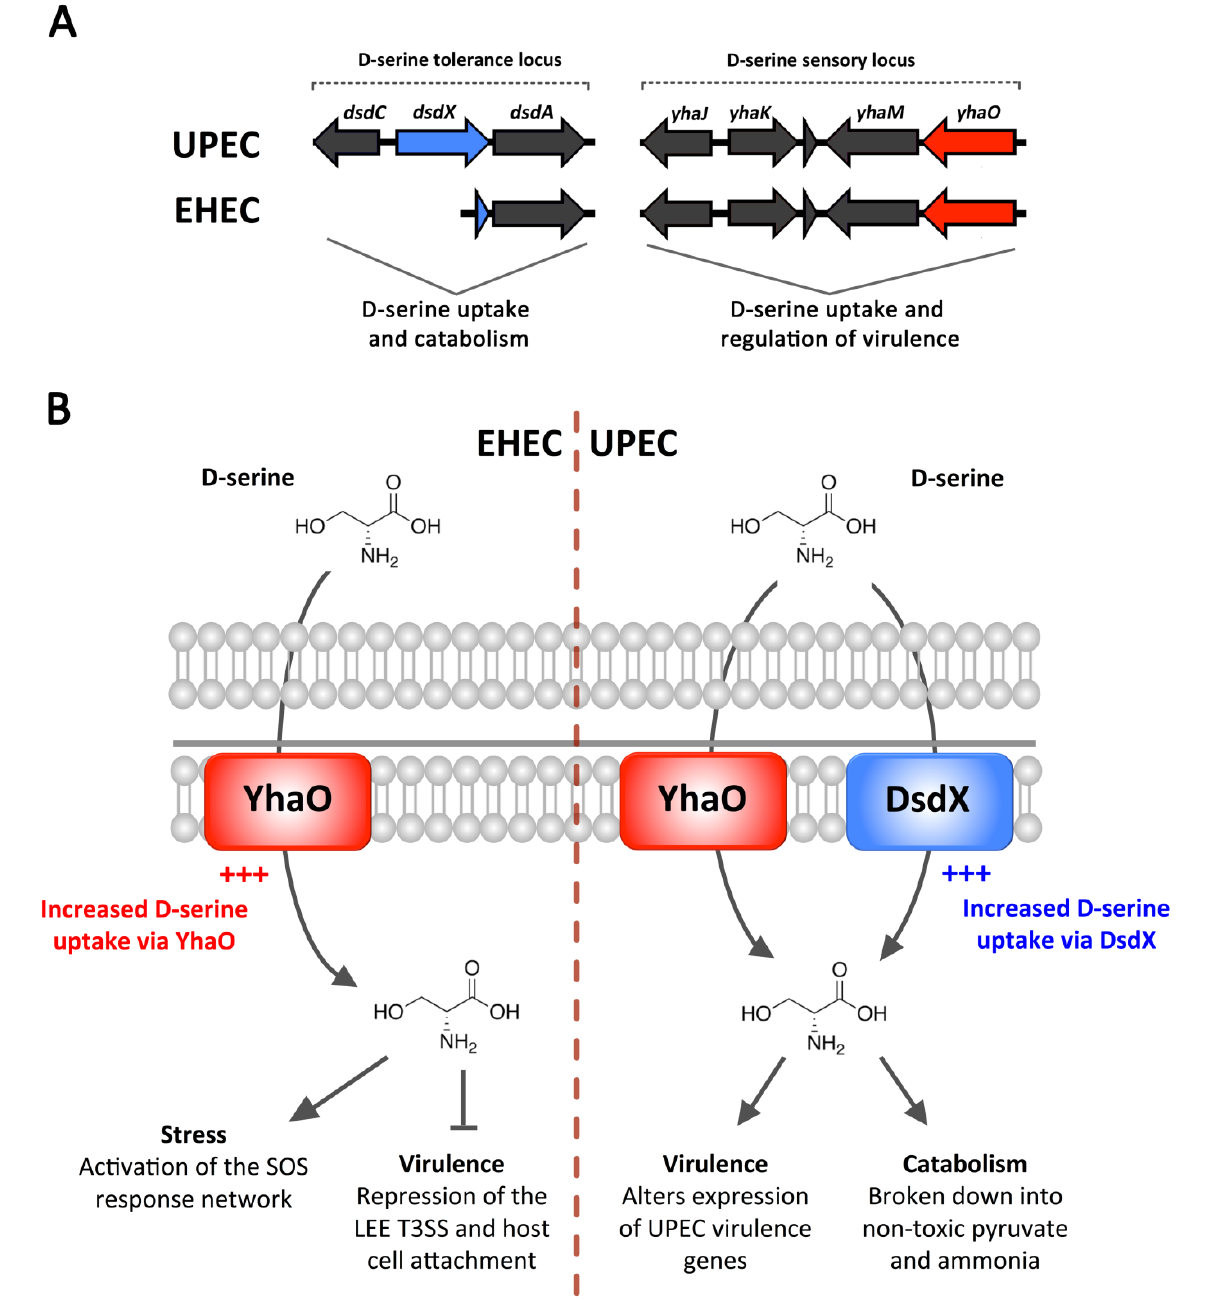
FIGURE 1: The genetics and schematics of D-serine uptake in E. coli . (A) Genetic organization of the D-serine tolerance and D-serine sensory loci in pathogenic EHEC and UPEC. D-serine tolerance is achieved via uptake ( dsdX - blue) and catabolism ( dsdA ) of D-serine under the con- trol of a transcriptional regulator, DsdC. This system is truncated in EHEC. D-serine uptake but not catabolism is achieved via YhaO (red), which is also required for virulence of EHEC . (B) Model of D-serine uptake and its downstream effects in EHEC and UPEC. UPEC transports D- serine via DsdX and YhaO, but only DsdX is responsive in this genetic background. UPEC uses D-serine as a positive virulence and fitness trait. EHEC regulates D-serine transport via YhaO and accumulates it intracellularly as a signal for stress and regulator of